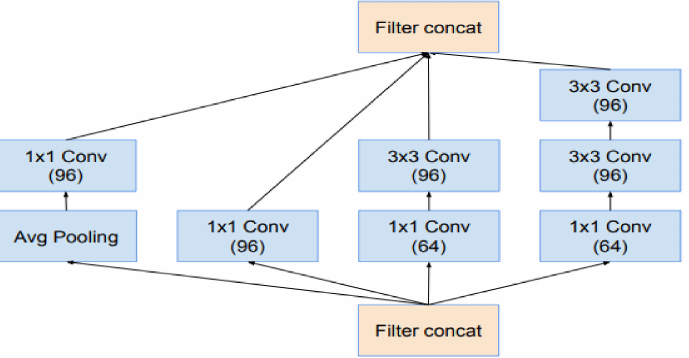
Figure 8. The schema for the 35 × 35 grid modules of the pure Inception-v4